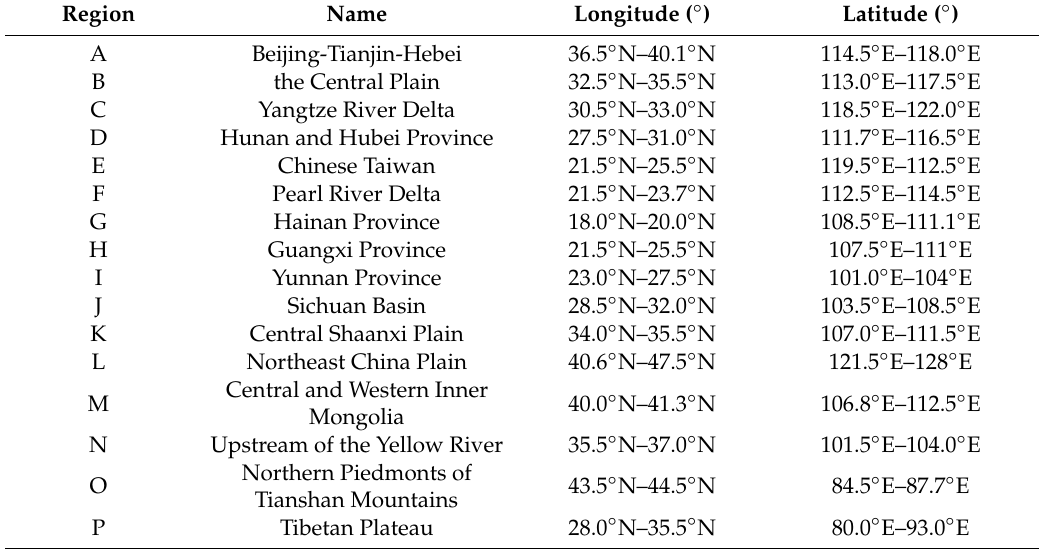
Table 1. Selected regions used for analyzing the temporal variations of aerosol types over China from 2008 to